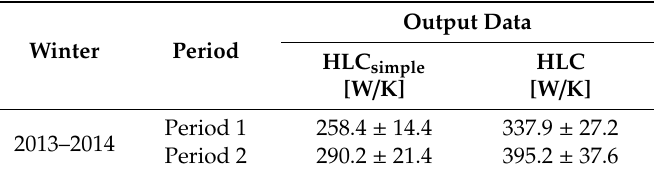
Table 8. The HLC simple (simple Heat Loss Coe ffi cient) and HLC (Heat Loss Coe ffi cient) estimated values for